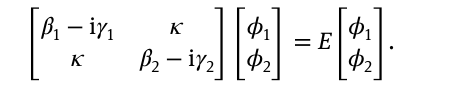
2 × 2 Hamiltonian [35, 36], given